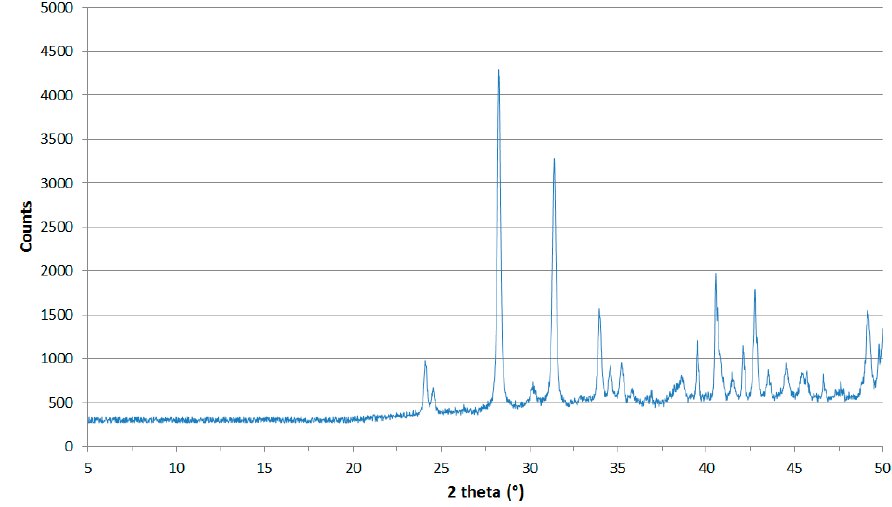
Figure 4. Rietveld refinement, shown in the range 5°–50° 2 θ . Table 1. Crystal data and data analysis parameters for the Cu/Zr oxide and a comparison with the ZrO 2 structure (Refinement agreement indices and 2 θ range are the minimum and the maximum values from different certified